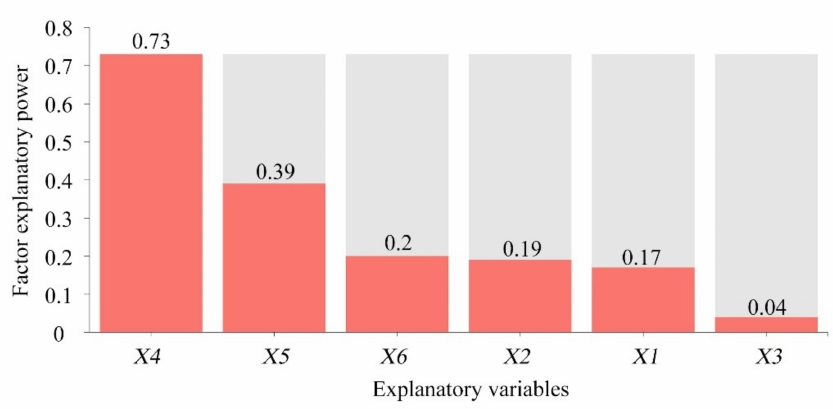
Figure 10. The explanatory powers of various influencing